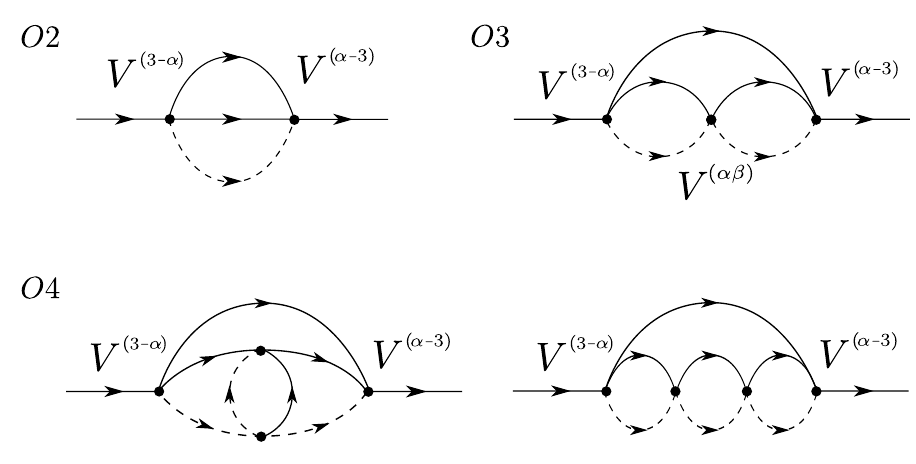
( k ) from the hybridization terms in (8) to the renormalized Figure 6: Three contributions δ E 3 1 one-magnon dispersion ω eff as given in (23). The solid lines stand for the propagation of an k α -magnon while the dashed lines stand for the propagation of a β -magnon. The upper left diagram is second order ( O 2) in the quartic terms V . The upper right diagram is third order ( O 3) in the quartic terms V ; the additional order results from an interaction between an α and a β magnon. The lower left diagram is fourth order ( O 4) in the quartic terms V ; the two additional orders result from two hybridization vertices (8). The lower right diagram is also of fourth order; it represents an iterated interaction between the α - and β